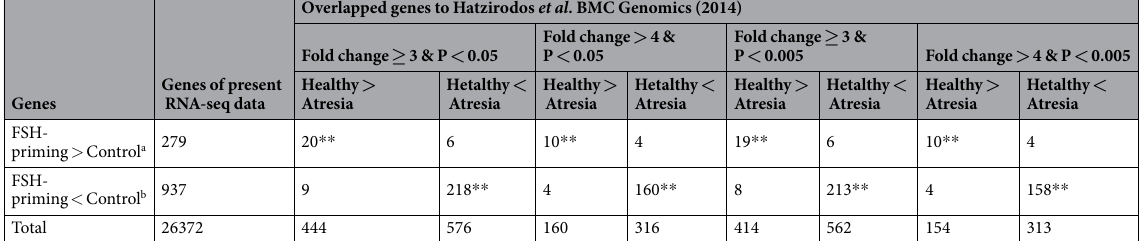
Table 3. Similarity of gene expression profile between granlulosa cells in atretic follicles and cumulus cells in unstimulated follicles. a (FSH-priming_FRKM + 0.1)/(Control_FRKM + 0.1) ≥ 2 and FSH-priming_FRKM ≥ 1. b (FSH-priming_FRKM + 0.1)/(Control_FRKM + 0.1) ≤ 0.5 and Control_FRKM ≥ 1. ** Present RNA-seq data significantly overlapped to the data of Hatzirodos et al . at P < 0.01.